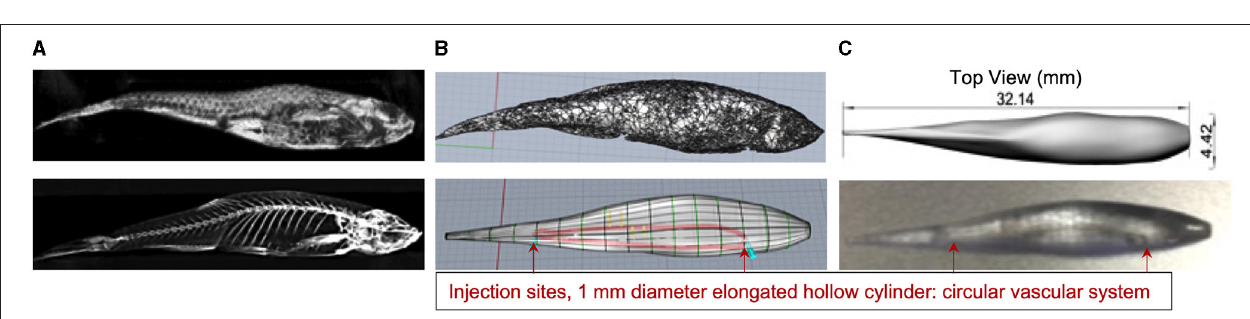
FIGURE 2 | (A) CT zebrafish reconstructed images were exported into OsiriX and converted to STL files for exporting into the Rhinoceros CAD software. (B) Displays the SLT file (top) and the prepared CAD file for 3D printing (bottom). (C) Shows a shaded top view of the CAD file with the fish dimensions (top) and the printed zebrafish model using Vero Clear which included a 1mm diameter hollow elongated cylinder inside for the injection of CT contrast and radioactivity